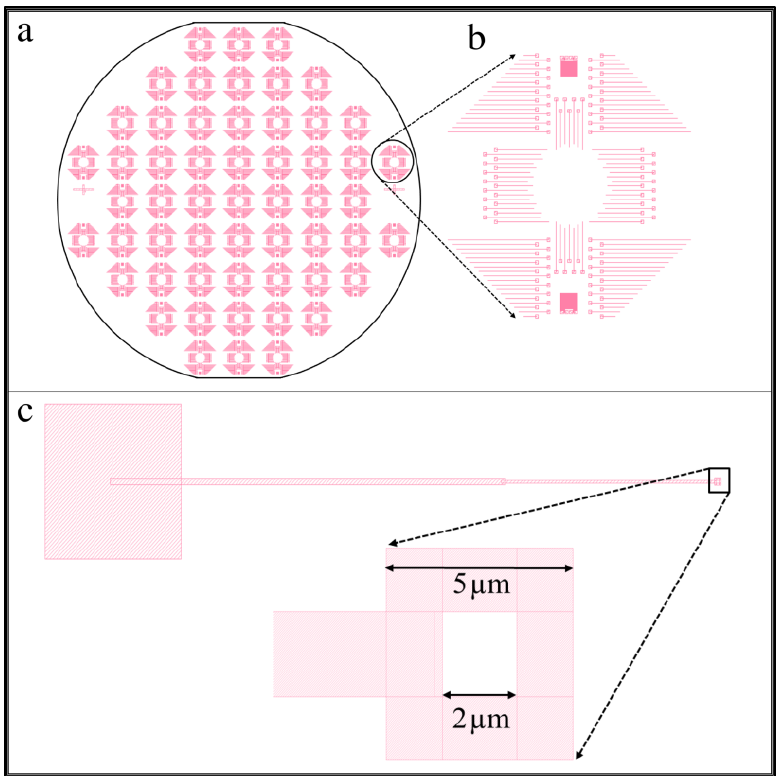
Figure 3. Mask 1 design pattern. ( a ) Fully patterned wafer with an array of 57 identical square sec- tions. ( b ) Zoomed-in view of a 1cm × 1cm region. ( c ) A pattern that will yield a single trench, well, and tip structure. well, and tip